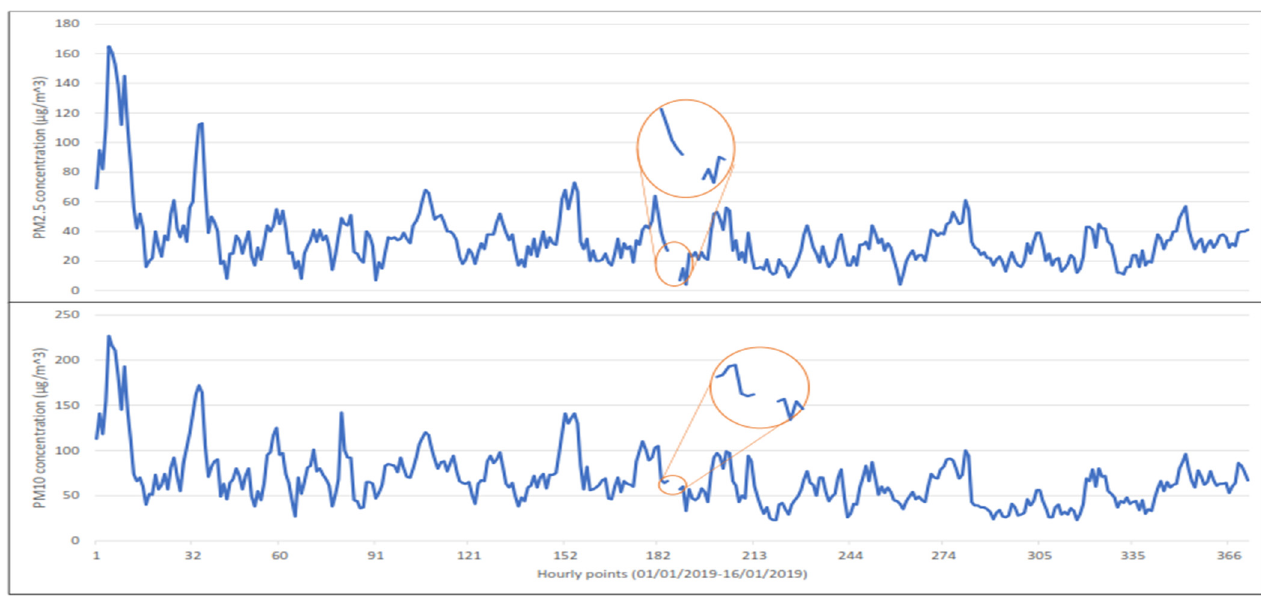
Figure 5. Behavior recorded during the first days of January 2019 by the MER environmental